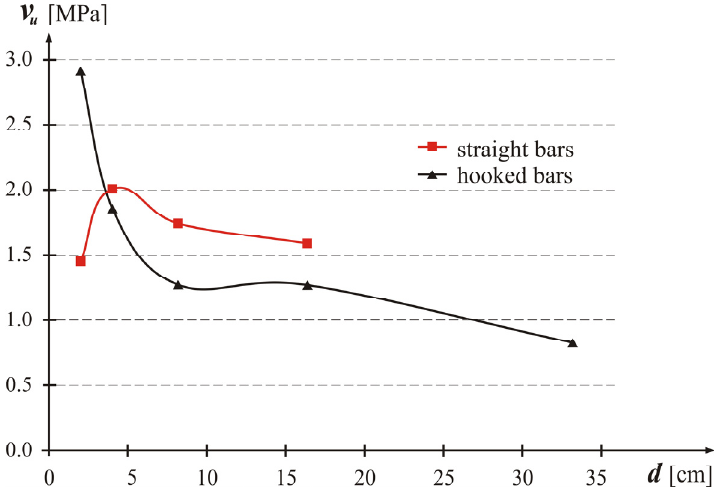
Figure 2. The influence of the beam’s depth on shear capacity on the basis of test results presented in [11].